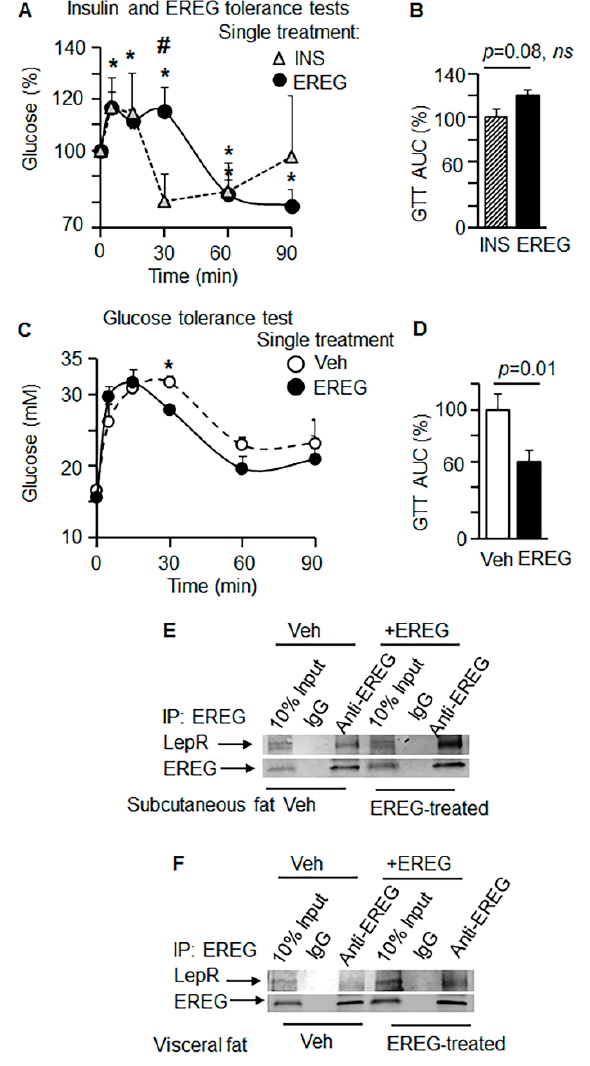
Figure 2. EREG regulated glucose uptake via binding with LepR in Lep ob mice. ( A ) EREG and insulin tolerance test in Lep ob mice ( n = 5 per group) treated with a single intraperitoneal injection of insulin (0.012 IU/g BW, triangle dashed line) or EREG (80 ng/g BW, closed circles. Asterisks, significant (* p < 0.05) compared to glucose levels before EREG treatment. # Hashtag, significant difference in glucose levels 30 min after treatment with EREG or insulin. Unpaired Student’s t -test. ( B ) Area under the curve (AUC) quantification of insulin (hatched bar) and EREG (black bar) tolerance tests. Unpaired Student’s t -test, ns . ( C ) GTT kinetics were measured in Lep ob mice ( n = 5 per treatment) treated with a single injection of PBS (Veh, open circles) or EREG (closed circles). Student’s t -test. * p < 0.05 from comparison between control and EREG treated mice at each time point. ( D ) Area under the curve (AUC) quantification of insulin (hatched bar) and EREG (black bar) tolerance tests. Unpaired Student’s t -test. ( E , F ). Immunoprecipitation of LepR was performed with anti-EREG antibody using homogenates from subcutaneous fat ( C ) and visceral fat ( D ). Fat tissue was isolated from non-treated Lep ob (Veh) as well as Lep ob mice 15 min after injection of EREG (50